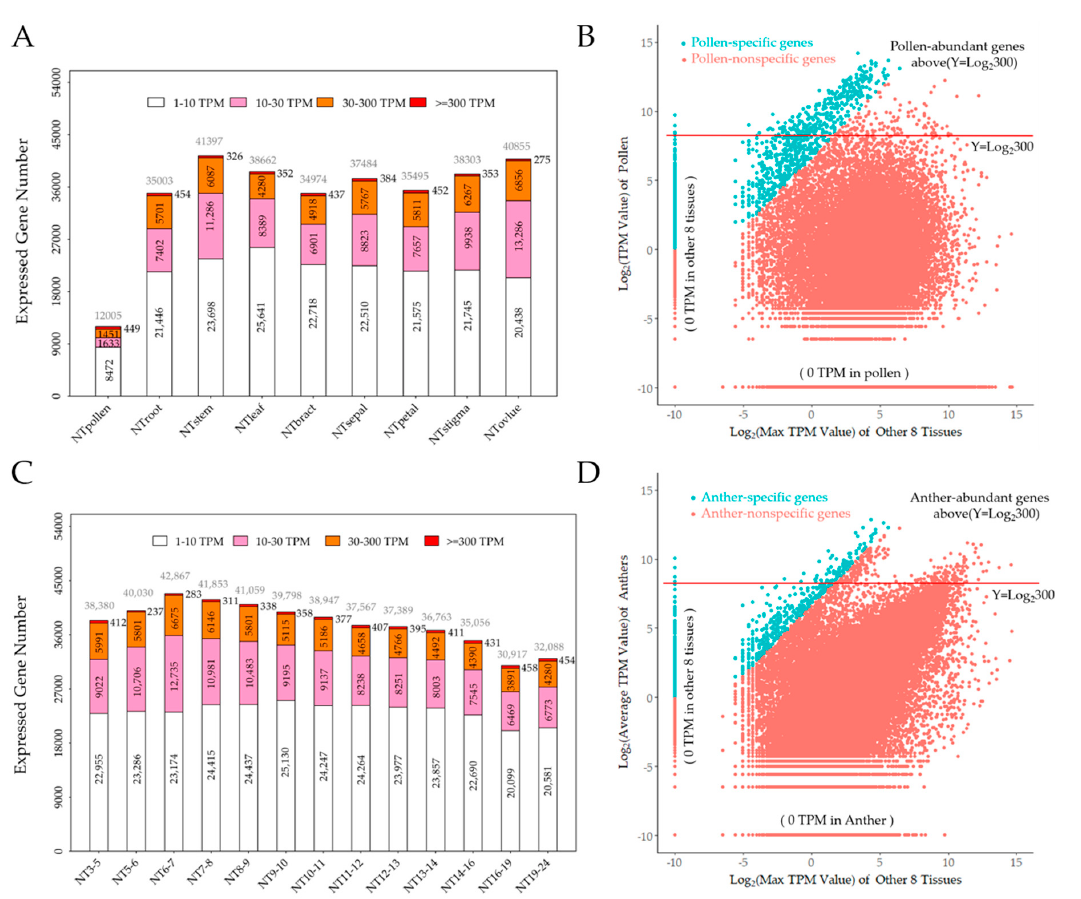
Figure 2. The distribution of transcriptional levels, PSGs and ASGs in H05 tissues. ( A ) The distribution of transcriptional levels grouped by abundances in the nine selected H05 tissues under NT conditions. Very highly expressed genes (VHEGs), highly expressed genes (HEGs), medium expressed genes (MEGs), and low expressed genes (LEGs) are indicated in dark red, orange, pink, and white color, respectively. VHEGs, HEGs, MEGs, and LEGs possess the transcript levels of ≥ 300, 30–300, 10–30, and 1–10 TPM, respectively. The total EG number of each tissue was indicated on the top of the columns in grey color. The transcript profiles of nine selected tissues were extracted from Table S1; ( B ) Two-dimension scatter plot of transcript abundance in pollen vs. the max of other eight tissues under NT conditions. The x-axis indicates the max of transcript abundances in the other eight tissues (except pollen and anthers), and the y-axis indicates the transcript abundance detected in pollen, with each point representing a unique gene model. Blue points and orange points repre- sent the pollen-specific genes (PSGs) and pollen-nonspecific genes, respectively. Pollen-abundant genes (PAGs) are located above the redline (y = log 2 300); ( C ) The distribution of transcriptional levels grouped by abundances in the 13 selected anthers of H05 under NT conditions. Very highly expressed genes (VHEGs), highly expressed genes (HEGs), medium expressed genes (MEGs), and low expressed genes (LEGs) are indicated in dark red, orange, pink, and white color, respectively. VHEGs, HEGs, MEGs, and LEGs possess the transcript levels of ≥ 300, 30–300, 10–30, and 1–10 TPM, respectively. The total EG number of each tissue was indicated on the top of the columns in grey color. The transcript profiles of 13 anthers were extracted from Table S1; ( D ) Two-dimension scatter plot of transcript abundance in the average of anthers vs. the max of other eight tissues under NT conditions. The x-axis indicates the max of transcript abundances in the other eight tissues (except pollen and anthers), and the y-axis indicates the average of transcript abundance in the 13 anthers, with each point representing a unique gene model. Blue points and orange points represent the anther-specific genes (ASGs) and anther-nonspecific genes, respectively. Pollen-abundant genes (AAGs) are located above the redline (y = log 2